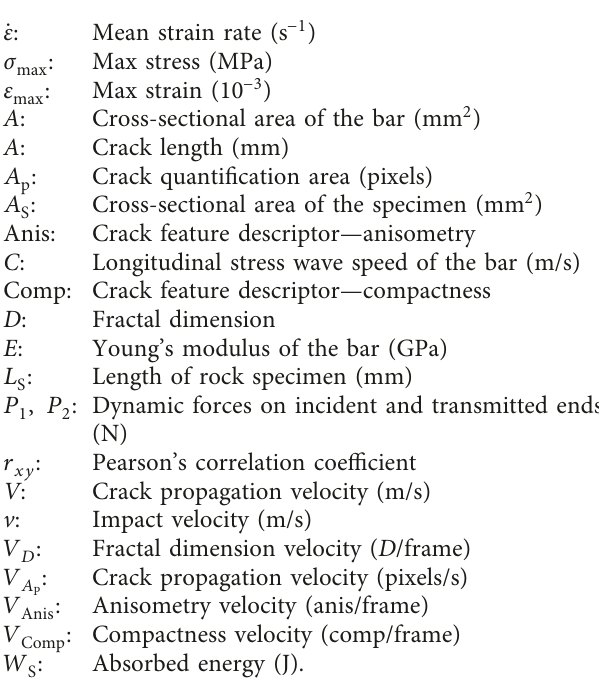
Figure 18: Curves of strain parameters with crack propagation velocity V V A P ; (b) ε max as a function of